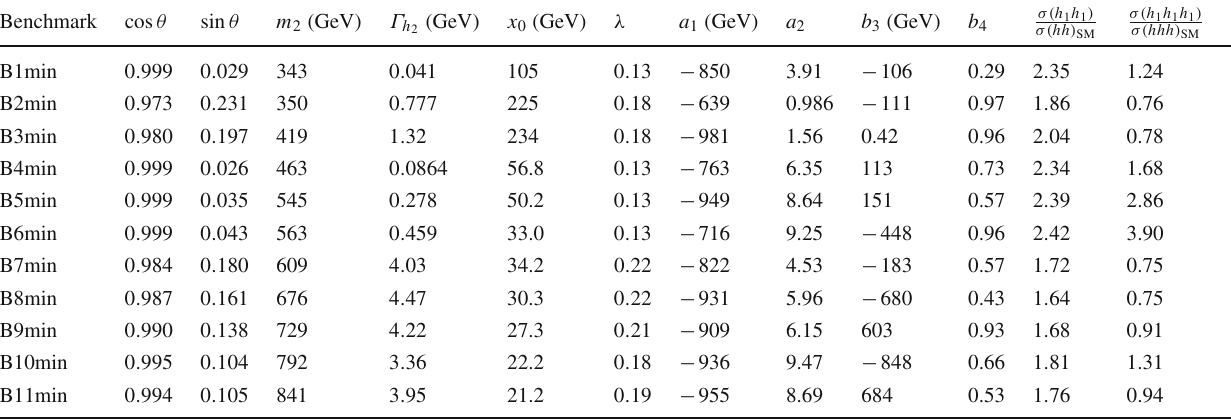
Table 6 Values of the various xSM independent and dependent param- eters for each of the benchmark values chosen to minimize the σ · BR ( h 2 → h 1 h 1 ) at a 100 TeV proton collider, taken from [44].